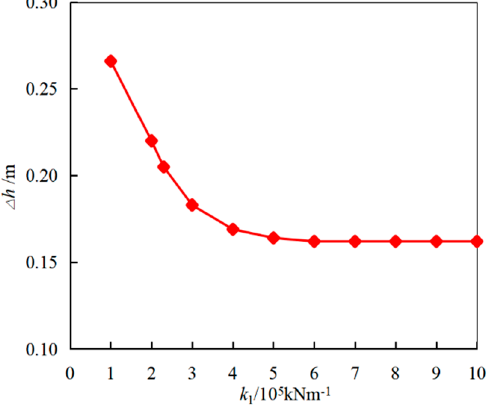
Figure 15. The relationship between step sinking and support stiffness.